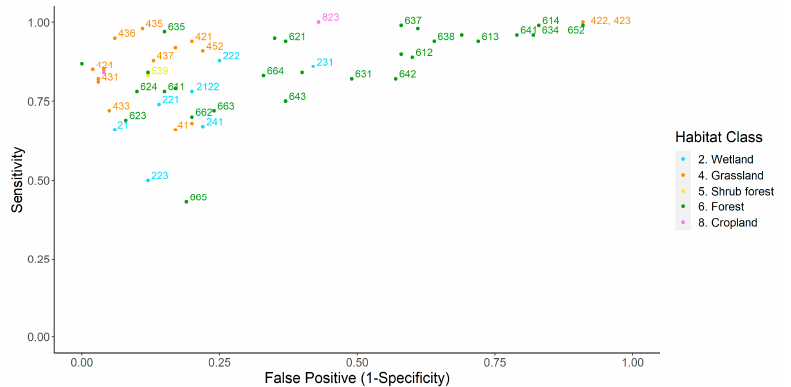
Figure 3. Specificity versus sensitivity resulting from the comparison between the habitat mapping (‘predicted’) and the Delarze maps (‘observed’). The presences and absences according to the two mapping products were compared in 625 mapping areas for 54 wetland (blue), grassland (orange), shrub forest (yellow), forest (green) and cropland habitat types (purple). Table 5. Comparison between the Habitat Map of Switzerland and the Swiss Land Use statistics for habitat types mapped according to land cover attributes. For each habitat type or group, the % of the total number of points (from the 100 m Swiss land use statistics grid) of that type/group where the mapped habitat type matches the Swiss land use statistics classification is given. The final column lists the Swiss land use statistics classes that are considered a match in definition to the habitat group or